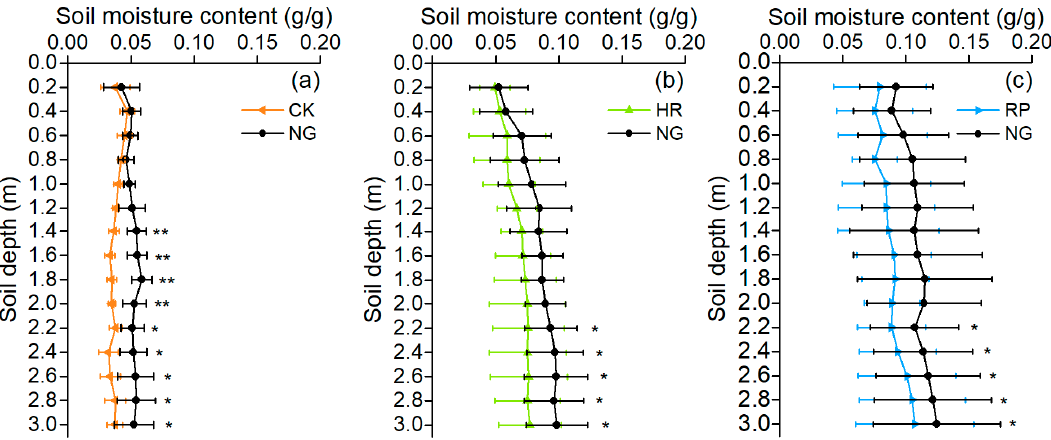
Figure 2. Soil moisture profiles for each vegetation type and the native grassland (NG) control. ( a ) korshinsk peashrub ( C. korshinskii , CK); ( b ) sea buckthorn ( H. rhamnoides , HR); ( c ) black locust ( R. pseudoacacia , RP). The bars denote the standard deviation of the mean ( n = 5). *, p < 0.05; **, p < 0.01.